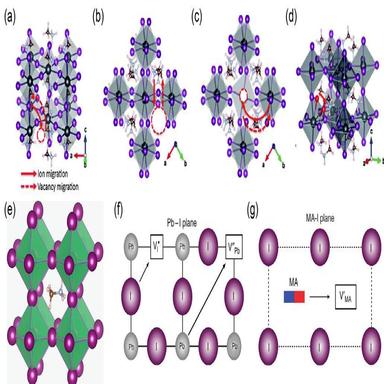
Migration pathways for VI (a), VMA, (b), VPb (c) and Ii (d).. Copyright 2015, Royal Society of Chemistry. (e) Perovskite structure of CH3NH3PbI3. (f and g) Migration mechanisms for I, Pb2+ (f) and MA+ (g) mediated by vacancy . Copyright 2015, Springer Nature Limited.